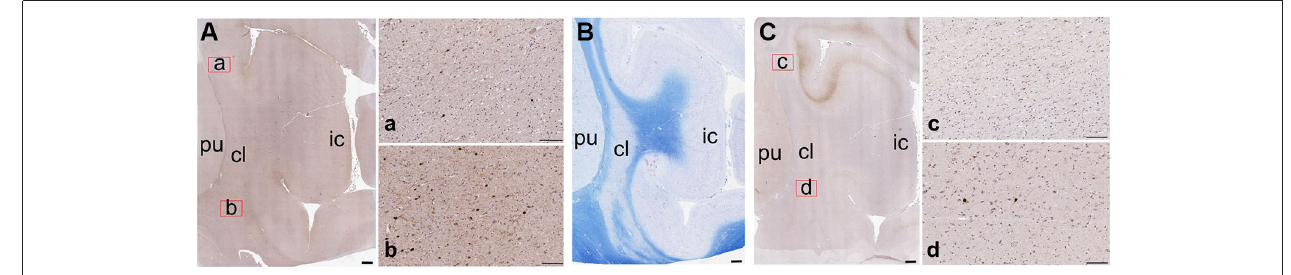
Luxol Fast Blue; (C) PV-immunoreactive neurons; c and d are enlargements of the corresponding red rectangles in C ; pu; putamen; cl: claustrum; ic: insular cortex. Scale bars: A, B, C = 1 mm; a, b, c, d, = 100 µ m.